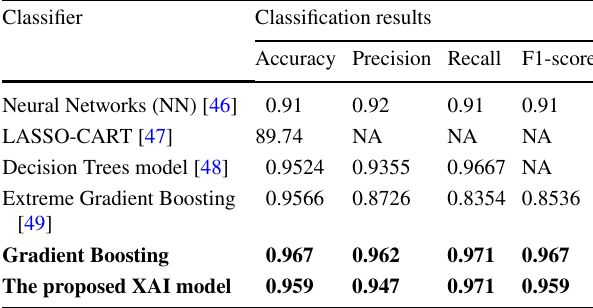
Table 9 Comparison between the state-of-art models and the pro- posed XAI model